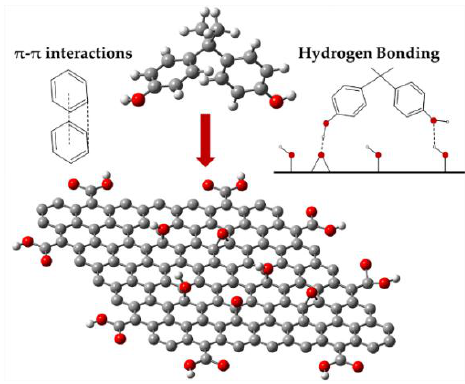
Figure 9. The oxygen-containing functional groups (OCFGs) on the GO surface analyzed by Fourier transform infrared spectroscopy (FTIR).